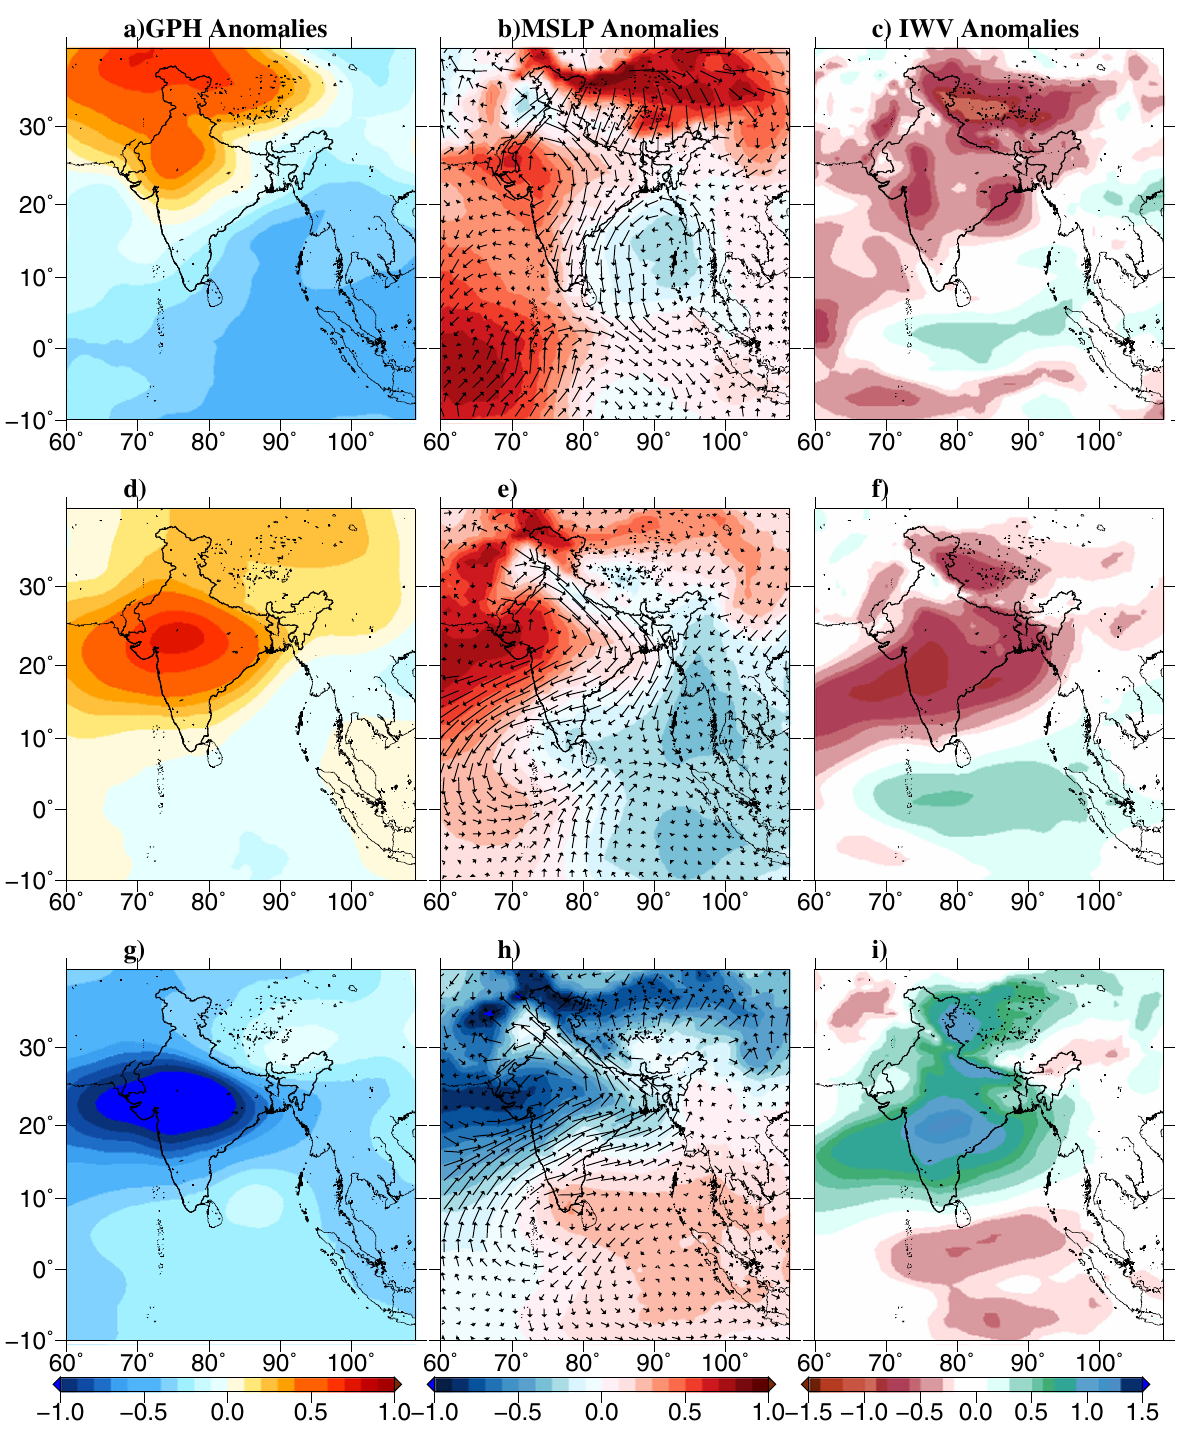
Fig. 2 Atmospheric anomalies composites for peak fl ash droughts during 1979 – 2016. a – c Anomaly composites of geopotential height (m), mean sea level pressure (hPa), and integrated water vapor (kg/m/s) during the peak of fl ash droughts that occurred in India during 1979 – 2016, d – f same as a – c but for all extreme dry and hot pentads during 1979 – 2016, and g – i same as a – c but for all extreme wet and cool pentads during 1979 – 2016. Extreme dry and hot pentads were identi fi ed with soil moisture anomaly less than − 1 standard deviation and temperature anomaly more than + 1 standard deviation. Pentad anomalies for each atmospheric variables were estimated using ERA-5 reanalysis 1951 – 2100 period (Fig. 3). A 30-year moving window analysis standardized soil moisture and air temperature anomalies were shows a considerable rise in the frequency of extreme dry and estimated against the historical period of each CESM-LENS extreme hot pentads under the warming climate (Fig. 3). The ensemble member. frequency of extreme dry pentads is projected to rise by a factor The frequency of extreme hot, dry, and concurrent hot and dry of 2.5 (from the current period) by the end of the 21st century pentads were estimated using the CESM-LENS simulations for